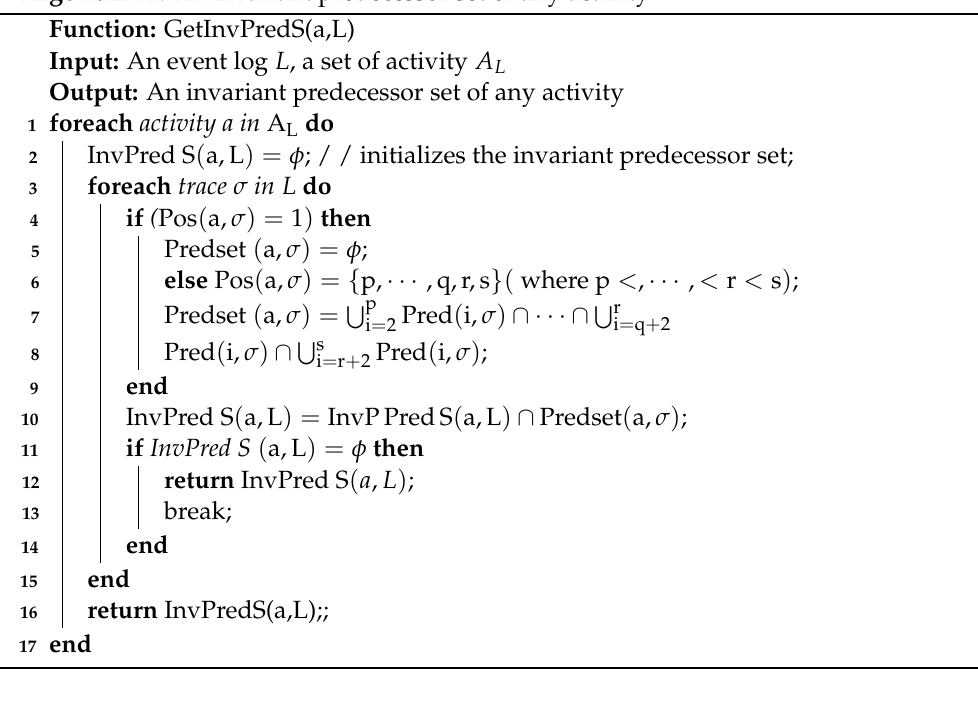
Algorithm 2: An invariant successor set of any